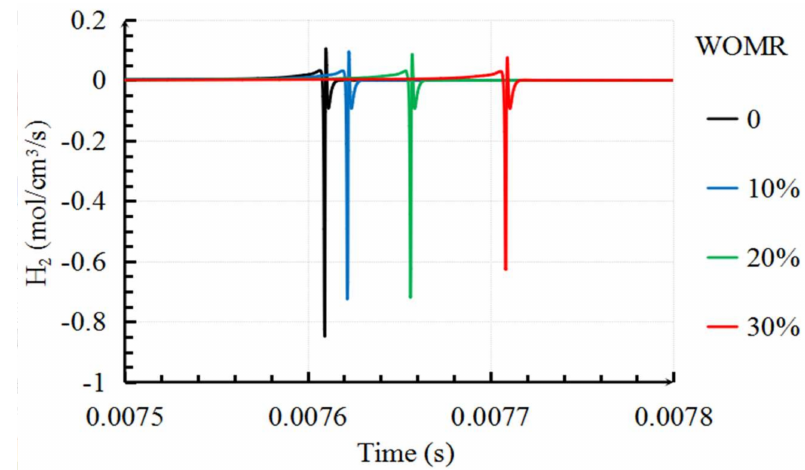
Figure 3. Reaction rate of H 2 at different WOMR ( λ = 1).